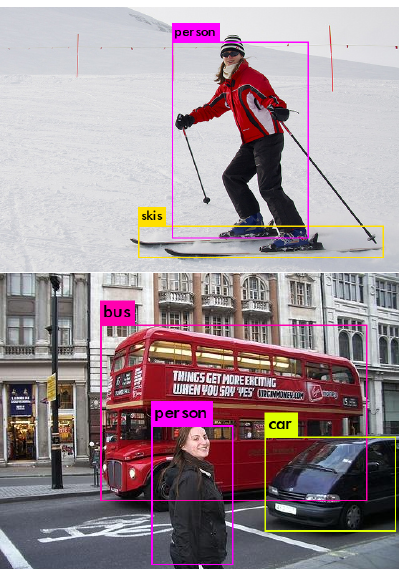
Figure 13. Sample YOLOv2 inference output of our hardware